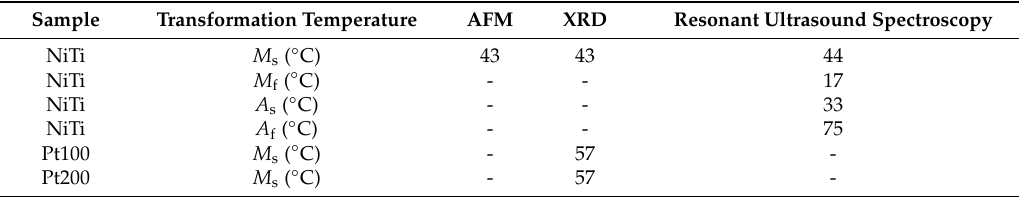
Table 3. The transformation temperatures of the NiTi sample determined with AFM, from XRD patterns and shifts of resonant frequency peaks (results taken from reference [53]) and the M s temperatures attributed to samples Pt100 and Pt200 and determined from the XRD patterns registered at various